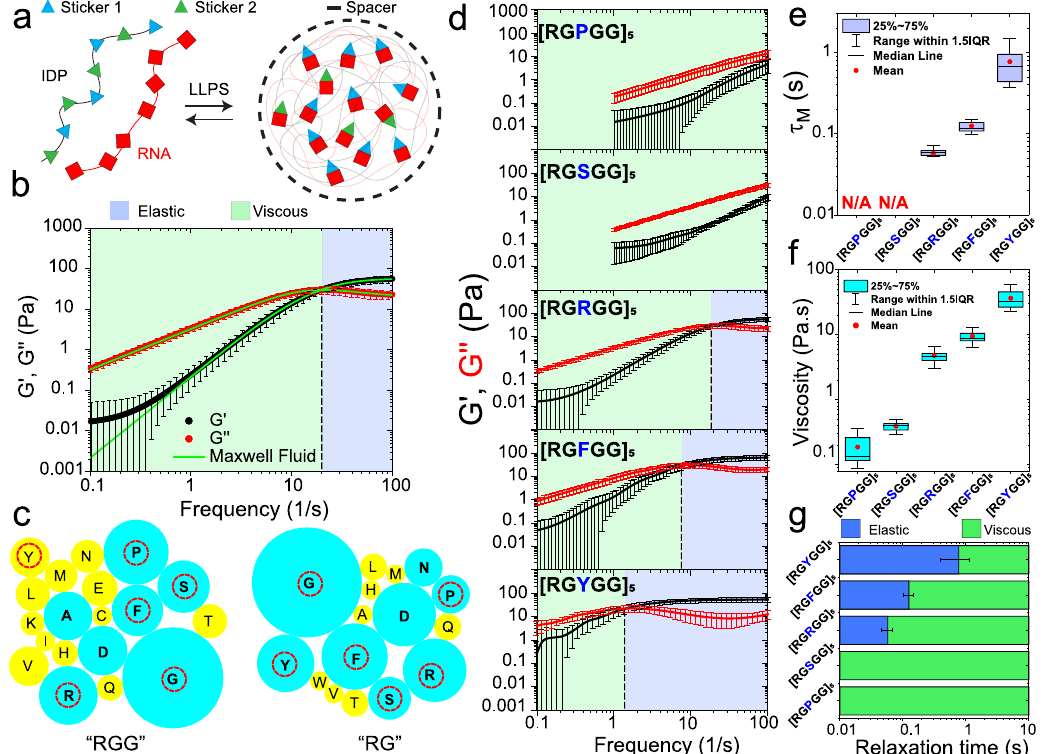
Fig. 2 Sequence-dependent control over linear viscoelastic (LVE) behavior of peptide-RNA condensates. a A scheme showing the sticker-spacer architecture of associative peptide and RNA chains. Here, sticker-RNA interactions drive the condensation. b A plot showing the average elastic modulus (G ’ , black) and the average viscous modulus (G ” , red) of [RGRGG] 5 -rU40 condensates ( n = 17 measurements over 3 independent samples). Green lines are fi ts to experimental data using a single-mode Maxwell fl uid model. The crossover frequency is indicated by the black dashed line and is the inverse of terminal relaxation time τ M . Shaded regions represent the dominant elastic regime (light-blue) and the dominant viscous regime (light-green), respectively. Error bars represent one standard deviation (±1 s.d.). c The relative abundance of different amino acids within the inter-RG/RGG spacers of RG/RGG motifs in human RNA-binding proteins represented as bubble charts. Sizes of individual bubbles represent the fraction of inter-RG/RGG spacers that contain the corresponding amino acid (see Methods section). Residues that occurred in more than 10% of the analyzed protein sequences (RG/RGG domains from 407 human RNA-binding protein sequences) are indicated in cyan. Residues marked with red circles are utilized for peptide design for the experimental studies reported here. d The average frequency-dependent viscoelastic moduli of [RGXGG] 5 -rU40 condensates where X = P/S/R/F/Y. The crossover frequencies are indicated by black dashed lines. Shaded regions represent the dominant elastic regime (light-blue) and the dominant viscous regime (light- green), respectively. Error bars represent ±1 s.d. e The terminal relaxation time τ M of [RGXGG] 5 -rU40 condensates as measured by pMOT (X = P/S/R/F/ Y). f The zero-shear viscosity of [RGXGG] 5 -rU40 condensates as measured by pMOT (X = P/S/R/F/Y). g An LVE state diagram indicating the timescales at which the elastic modulus dominates (blue) and the timescales where the viscous modulus dominates (green) in [RGXGG] 5 -rU40 condensates (X = P/ S/R/F/Y). Error bars represent one standard deviation (±1 s.d.). For d – g , the sample size is n = (29,16,17,17,16) measurements over 3 independent samples for X = (P,S,R,F,Y),